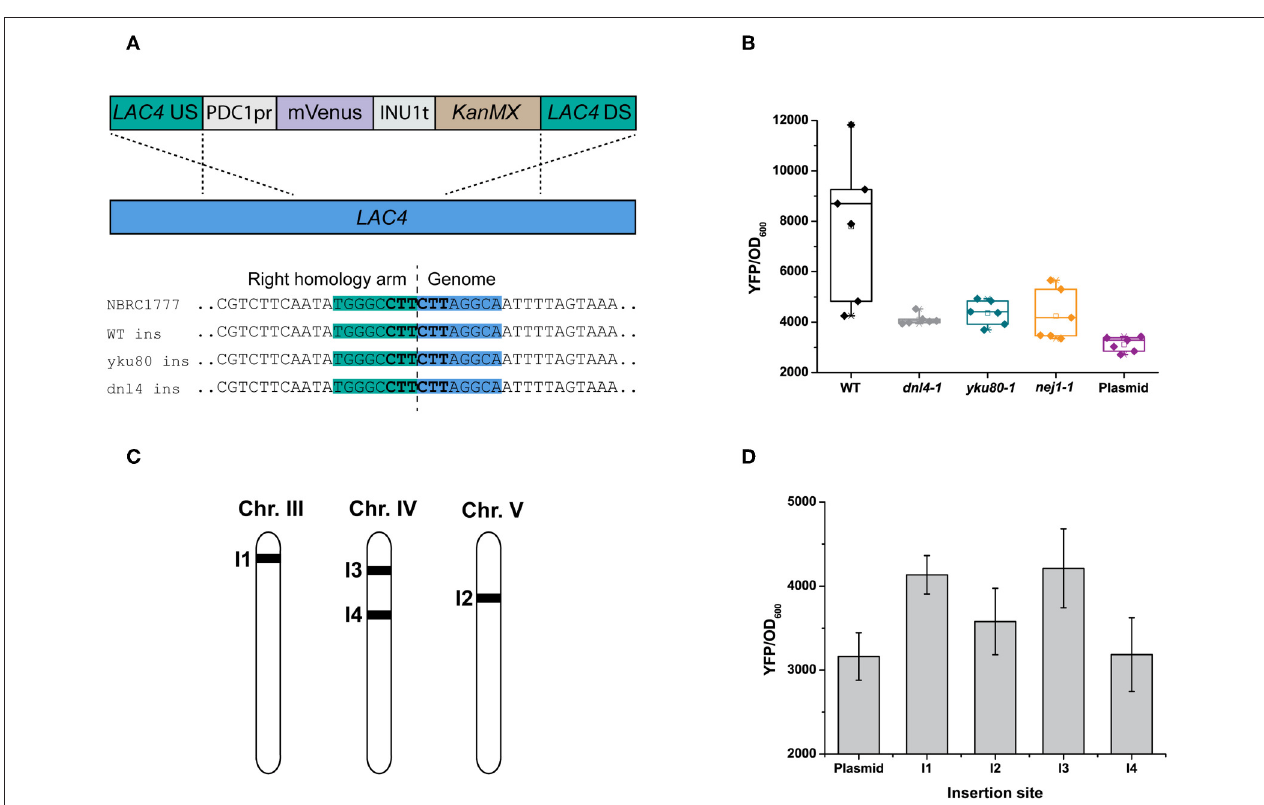
FIGURE 5 | Random and targeted integration in K. marxianus . (A) Using homology arms ∼ 880 bp in length, integration of a YFP reporter cassette (with marker) is seamless, with no sequence loss or modifications at the integration site irrespective of the genetic background (inset). (B) Inactivating YKU80 or DNL4 but not NEJ1 is essential to eliminate random integrations. When targeting an YFP expression cassette at the LAC4 locus, correct integration in a wild-type strain (as determined by genotyping) does not abolish random integration elsewhere, as seen by the spread in YFP fluorescence measured from five transformed colonies. YFP expression for the same cassette expressed on a centromeric plasmid is provided as a reference. (C) Genomic locations of insertion sites for gene expression cassettes, selected as described in the main text. (D) The effect of genetic context on expression levels of the same gene. The bar plots are plotted as the mean ± s.d. of at least three